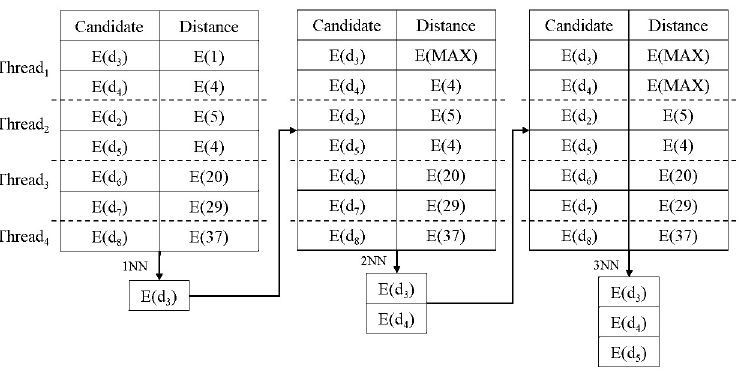
Fig 8. Example of k-nearest neighbor search in kNN verification phase.